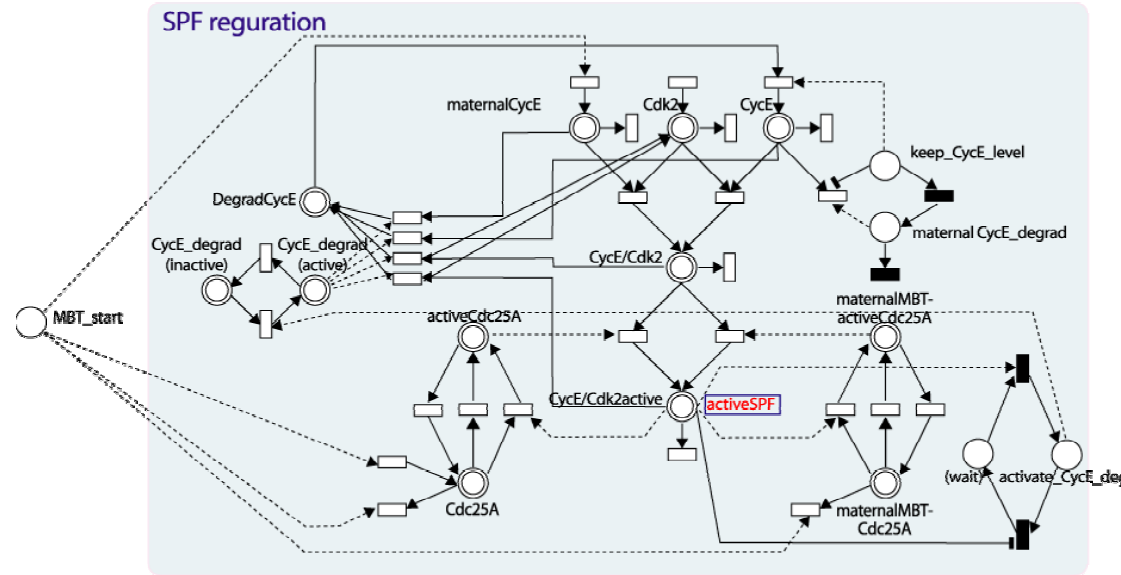
Figure 2. An HFPN model for SPF regulation. This pathway contains reactions of protein composing and decomposing, enzyme reaction, and protein degradation. Refer to the corresponding explanations in Section 3.2 for these